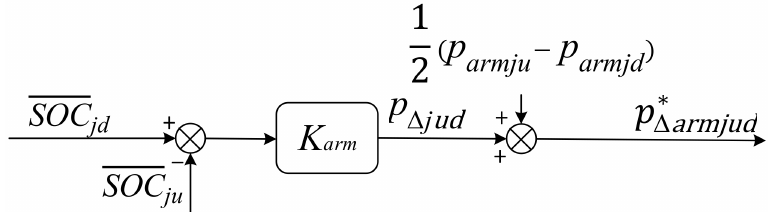
Figure 5. The upper and lower arms SOC balancing